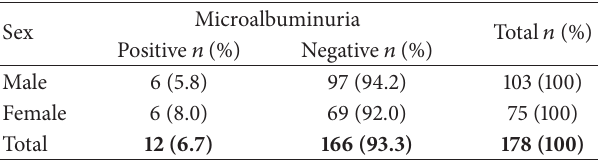
Table 6: Microalbuminuria in early morning and spot urine